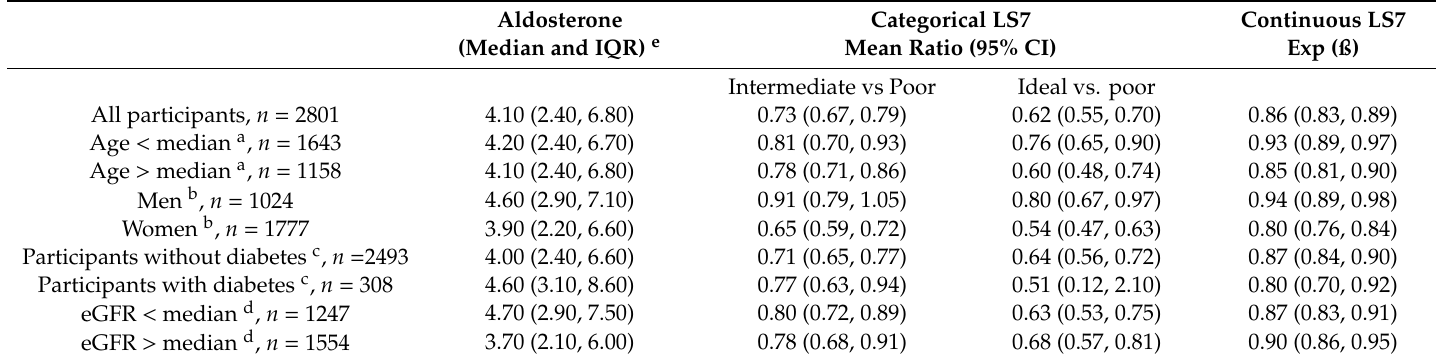
a The p -values for the interaction of age with the association of categorical and continuous LS7 scores with aldosterone were p = 0.1749 and p = 0.0164, respectively. b The p -values for the interaction of sex with the association of categorical and continuous LS7 scores with aldosterone were p < 0.0001 and p < 0.0001, respectively. c The p -values for the interaction of diabetes with the association of categorical and continuous LS7 scores with aldosterone were p = 0.2712 and p = 0.6031, respectively. d The p -values for the interaction of eGFR with the association of categorical and continuous LS7 scores with aldosterone were p = 0.6665 and p = 0.2829, respectively. e p -values for di ff erences in median aldosterone using wilcoxon rank sum test,